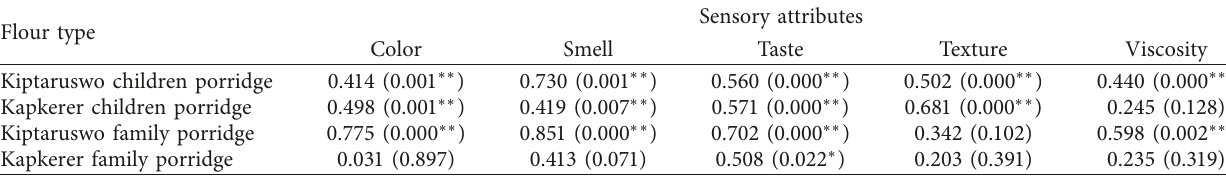
Table 4: Correlation of most liked porridge attributes with most acceptable porridge. Flour